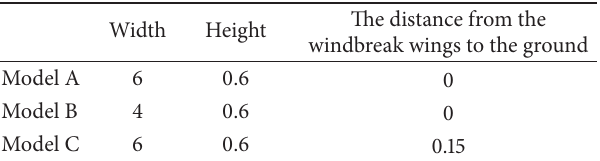
Table 3: Average and maximum wind velocities by the type of models (unit: